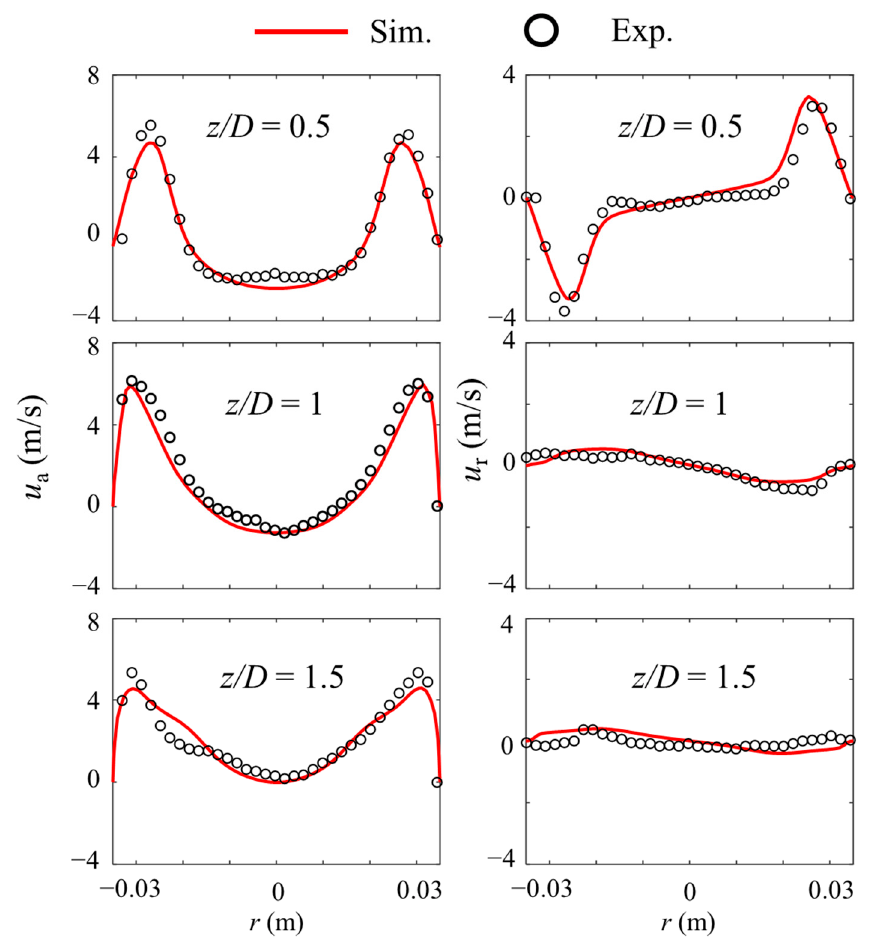
Figure 3. Radial distribution of mean axial ( left ) and radial ( right ) velocity components at differ- ent cross sections of the combustor. ( a ) z/ D = 0.5, ( b ) z/ D = 1 and ( c ) z/ D = 1.5.